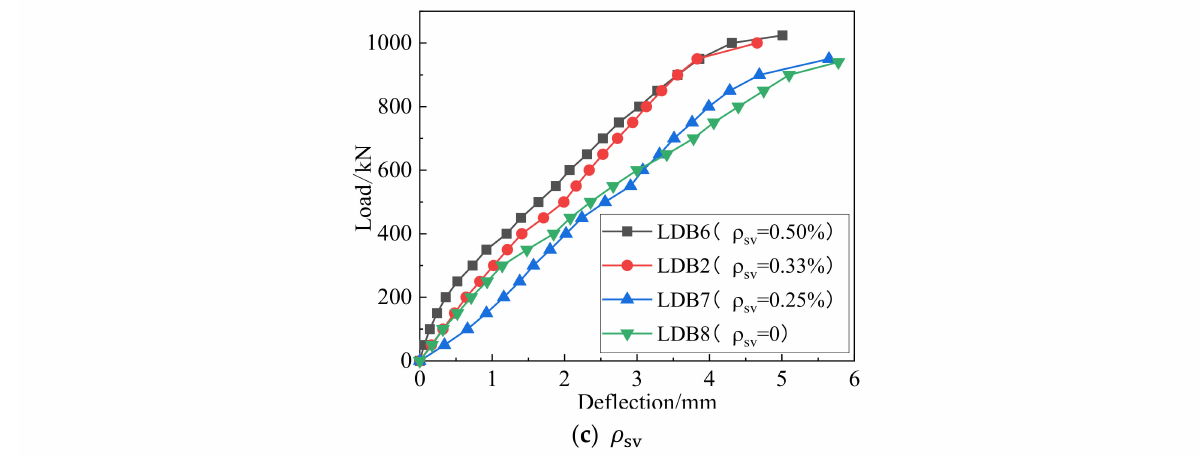
Figure 16. Relation curve between the three variables and horizontally distributed reinforcement